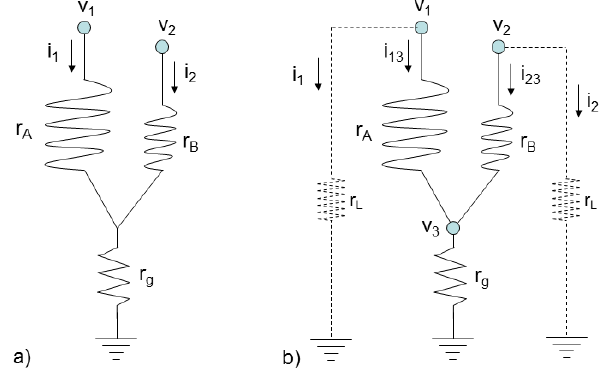
Figure 8. Grounding connection for a transformer. (a) Sharing a path through the grounding resistance and (b) with a node at the neutral